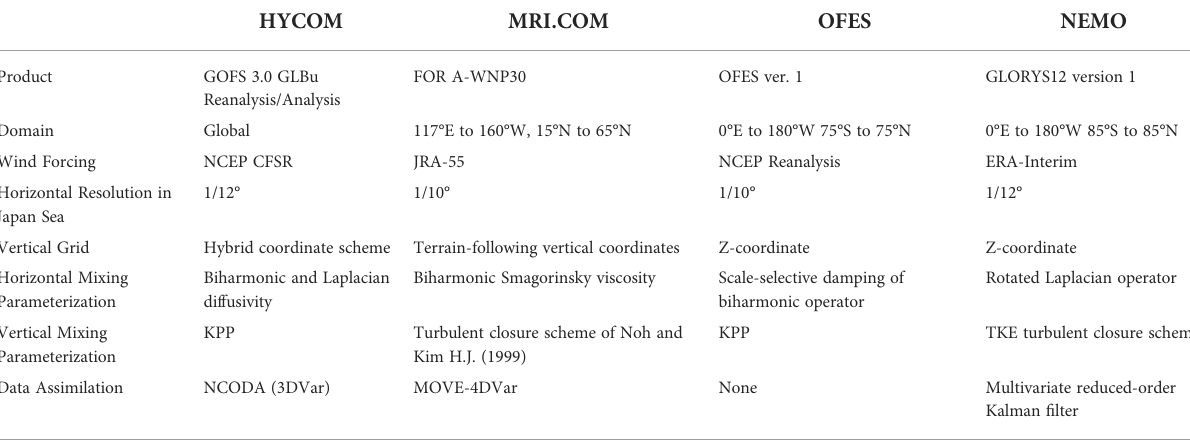
TABLE 1 Fundamental con fi gurations of four models assessed in this study, including the information on assessed product, the wind forcing dataset, the horizontal and vertical grid schemes, the parameterization schemes, the data assimilation method, and the model